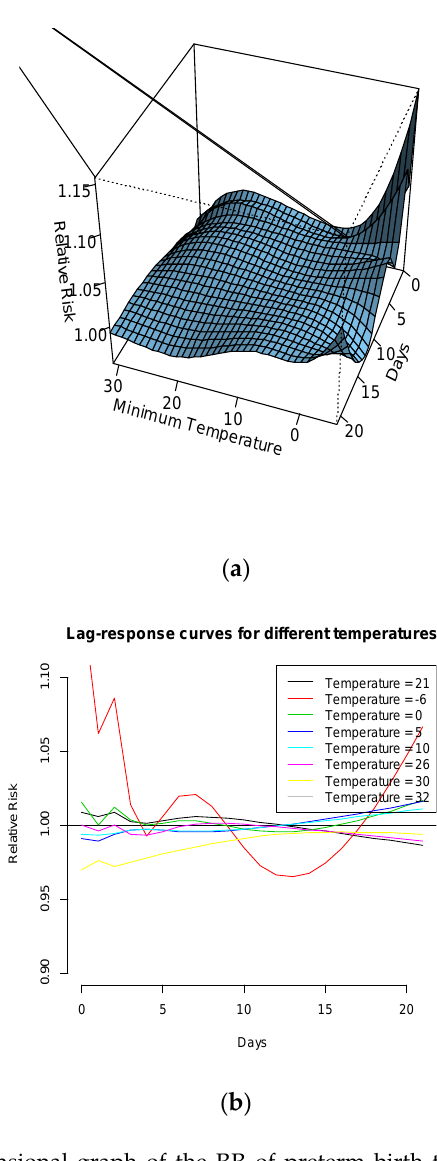
Figure 3. ( a ) Three-dimensional graph of the RR of preterm birth to the exposure of minimum temperature and ( b ) RR of preterm birth for the exposure to different minimum temperatures (Minimum = –6 ◦ C, Median = 21 ◦ C, P90 = 26 ◦ C, P99 = 30 ◦ C and the maximum = 32 ◦ C of minimum temperatures), using the median minimum temperature value at 14 ◦ C of the whole annual series as a reference.